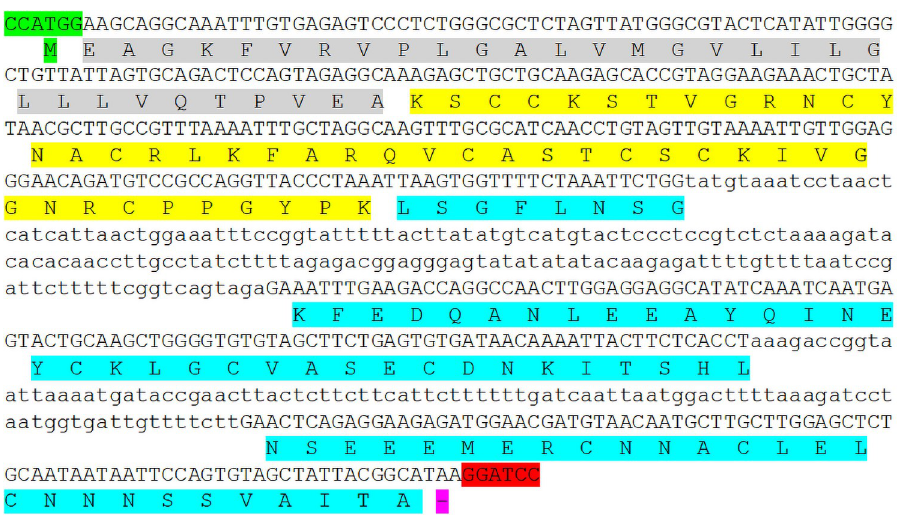
Fig 5. PsoTHI1.7 encoded by the genomic clone from Papaver somniferum . Capital letters are exons while lowercase letters indicate introns. Signal peptide marked grey, thionin domain marked yellow and acidic domain marked cyan. NcoI site marked green and BamHI site marked red.